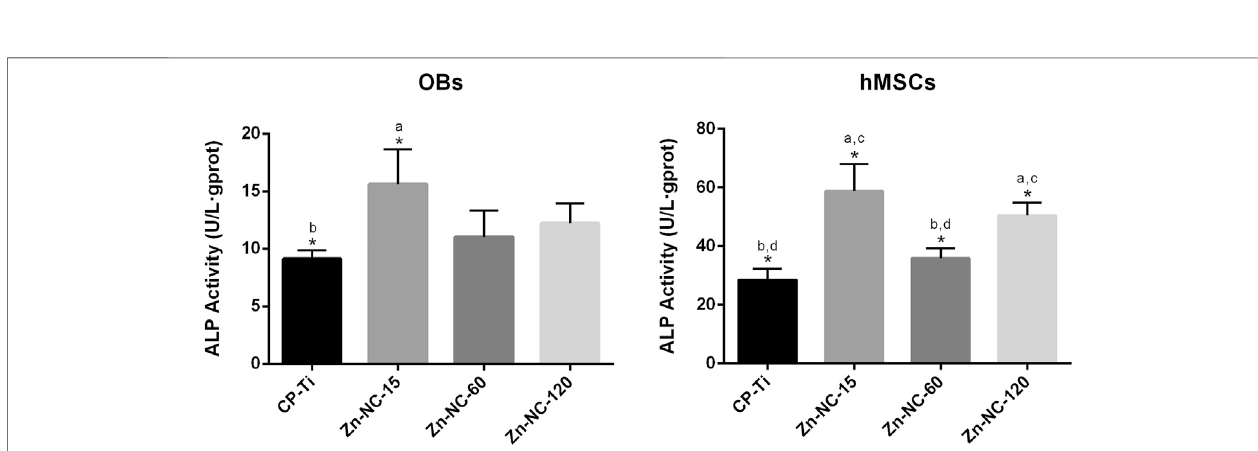
FIGURE10| TheALPactivityoftheOBsandhMSCsculturedfor7 daysonthedifferentsamples(n (cid:2) 3).* p < 0.05; a P < 0.05vs.CP-Ti; b P < 0.05vs.Zn-NC-15; c P < 0.05 vs. Zn-NC-60; d P < 0.05 vs. Zn-NC-120.